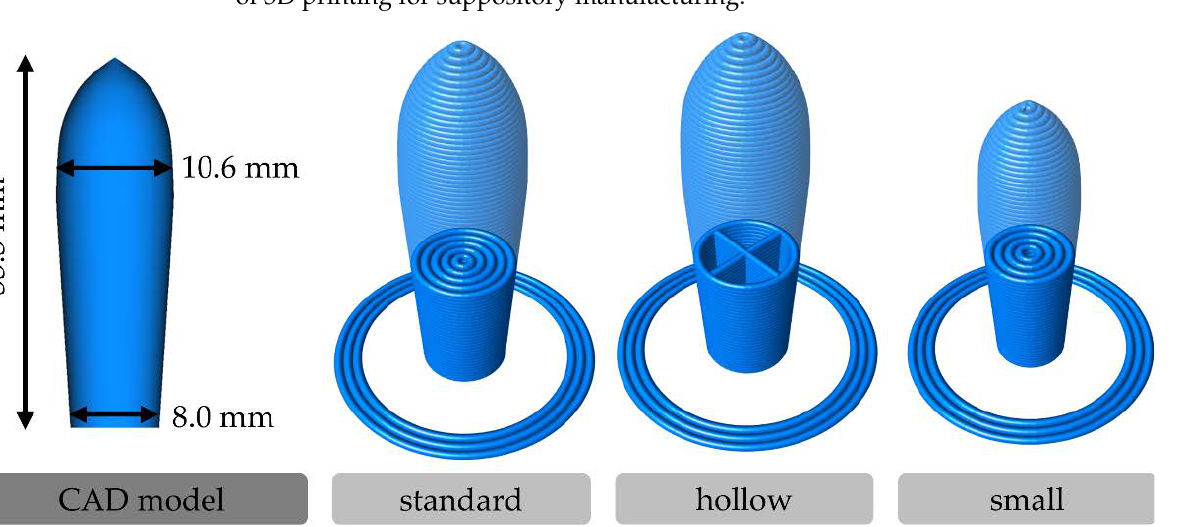
Figure 2. CAD model with dimensions of reconstructed torpedo-shaped suppository and schematic images of the “standard”, “hollow”, and “small” 3D printing designs of the suppositories.